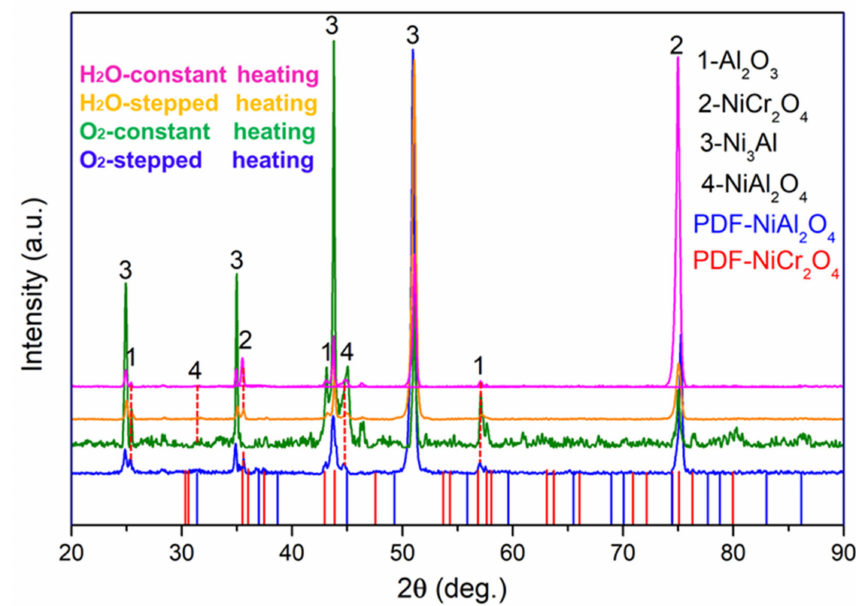
Figure 3. The surface XRD patterns of the oxide scale formed on NiCrAlHf bond coat alloy in different atmospheres and using different heating methods after 24 h of oxidation at 1100 ◦